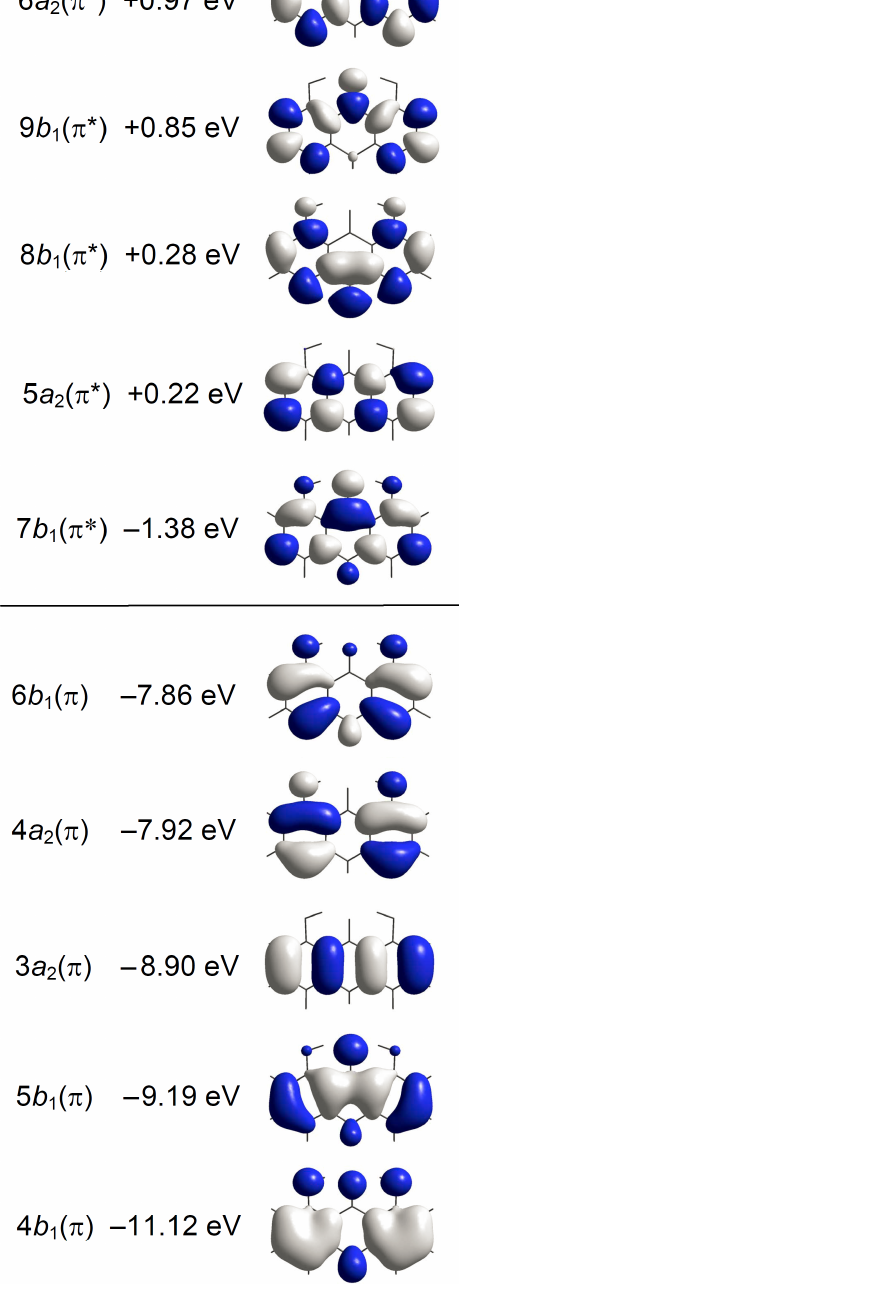
Figure 4 Energies and amplitude diagrams for the five highest occupied and five lowest unoccupied π type MOs of anthralin (A) computed with CAM-B3LYP/aug-cc-pVTZ. Different colors indicate amplitudes of different